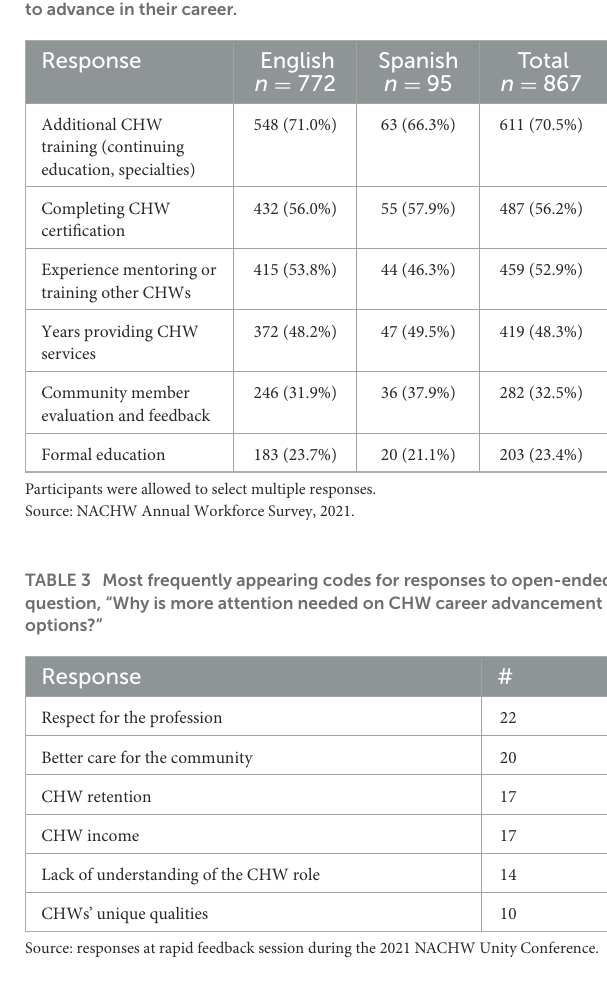
TABLE 2 The top factors that CHWs believe should be valued for a CHW to advance in their